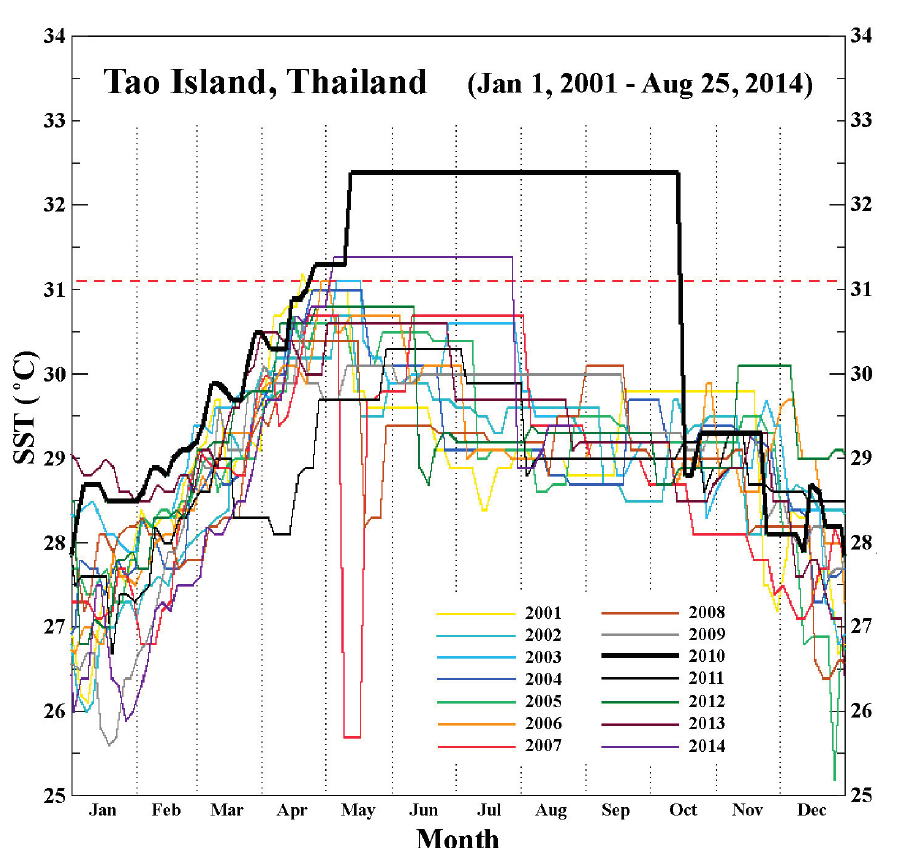
Figure 3. CRW’s twice-weekly, 50-km, night-only SST time series of 2001–2014 from a pixel near Tao Island, Thailand. The flat portions of the SST time series indicate the periods with no SST update. Note that the longest period with no SST update spanned from May to October 2010. The MMM (maximum of the monthly mean) + 1 °C (31.1 °C) is shown as a red dashed-line across the